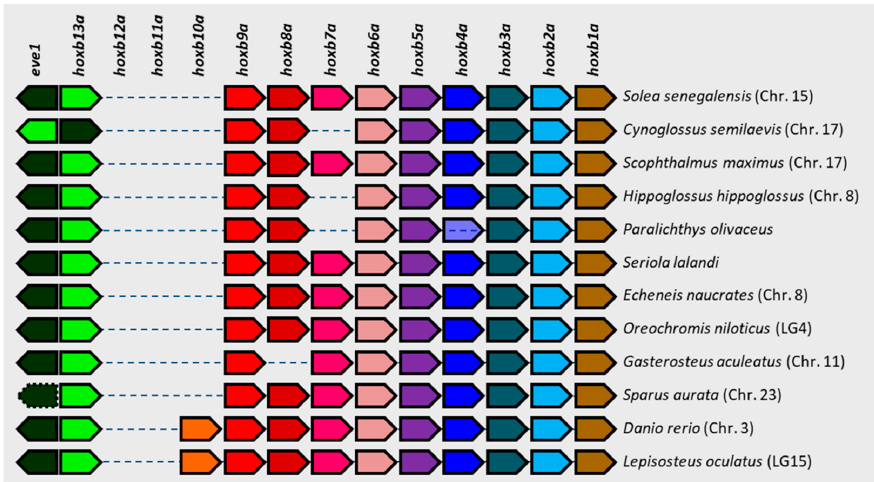
Figure 5. Schematic representation of the hoxba cluster synteny among different fish species. Each color represents the same gene in every species. Dotted box frames represent pseudogenes. Transparent boxes represent genes that were positioned by means of different scaffolds.